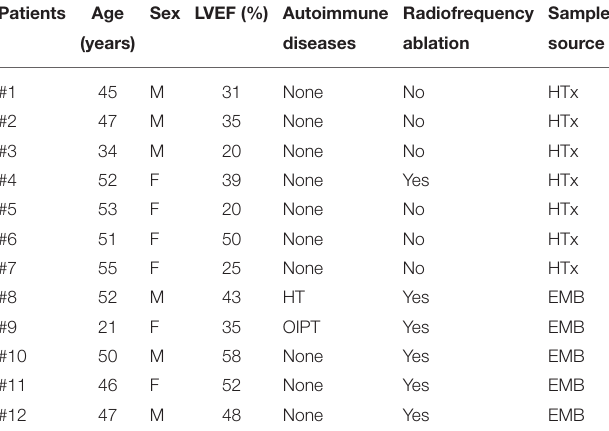
TABLE 1 | Patient